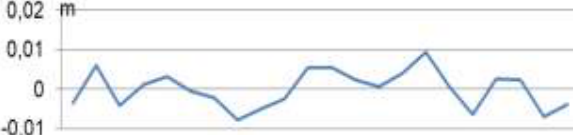
Figure 13. Averaged Pleiades y-parallax over 8km in east-west